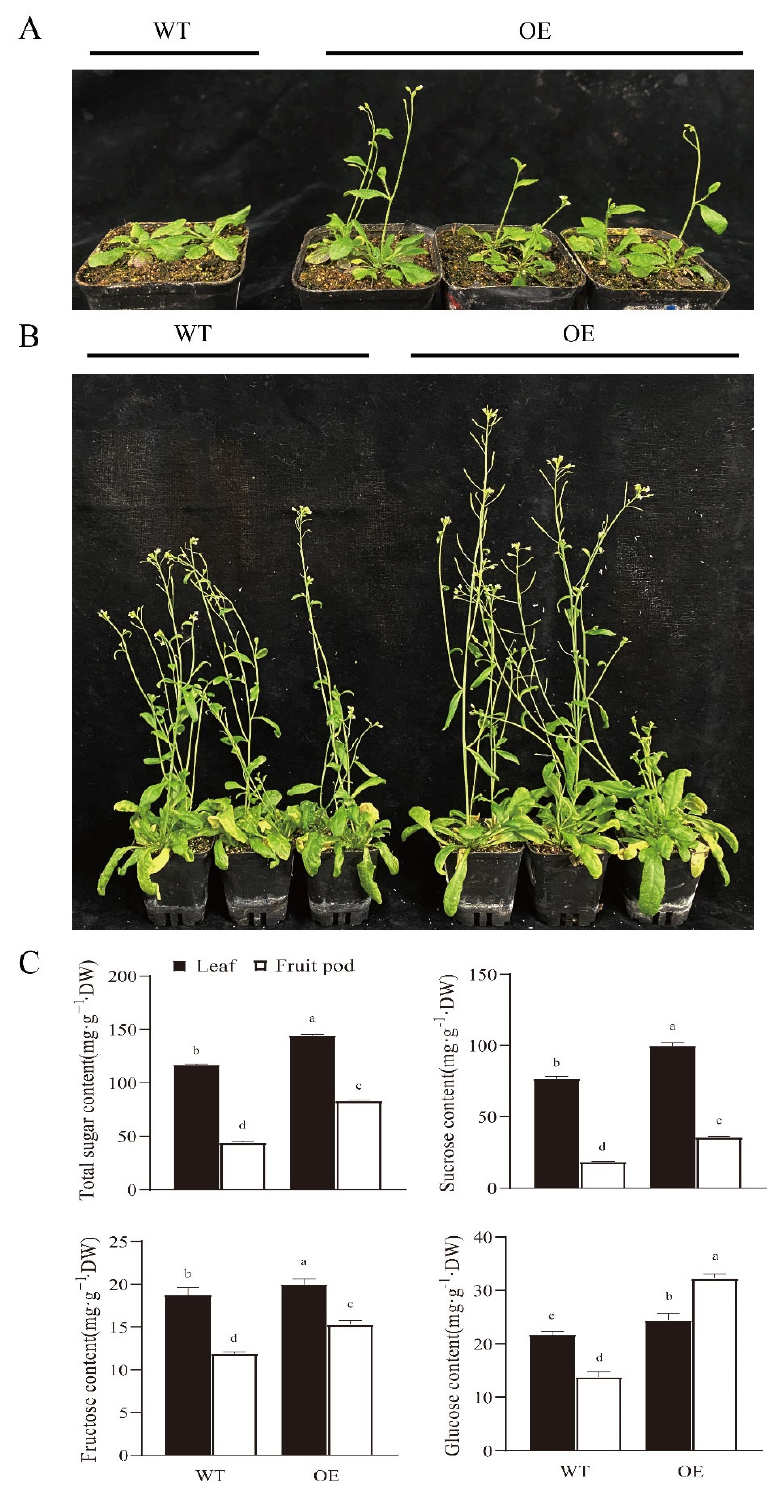
Figure 6. The phenotypes of RsSUC1b ‐ overexpressing (OE) transgenic Arabidopsis plants. ( A ) Morphological phenotypes of WT and three independent transgenic lines in vegetative growth stage ( A ) and in bolting stage ( B ), bar = 1 cm. ( C ) The soluble sugar (total sugar, sucrose, fructose and glucose) contents of the transgenic lines and WT plants in leaves and pods. DW, dry weight. Each bar shows the mean ± SD (n = 3). Value with different letters indicates a significant difference at p < 0.05 according to Duncan’s multiple range tests.